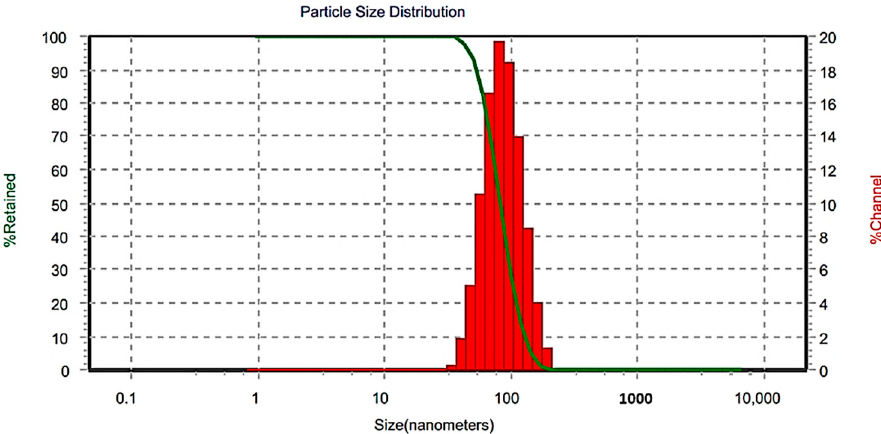
Figure 4. Size distribution of the optimized formulation.